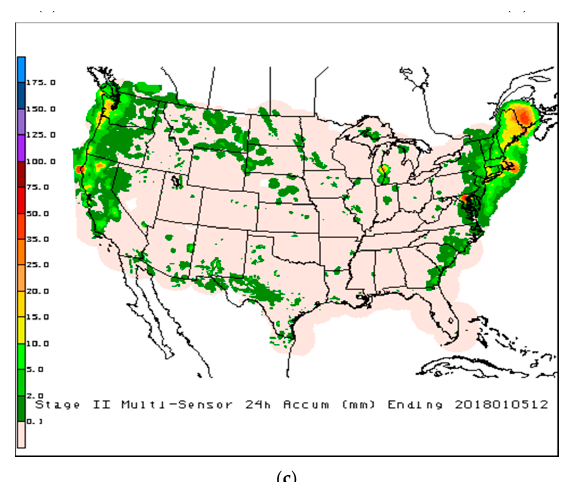
Figure 3. IMS snow maps on ( a ) 2 January and ( b ) 4 January 2018, respectively, and ( c ) NCEP Stage